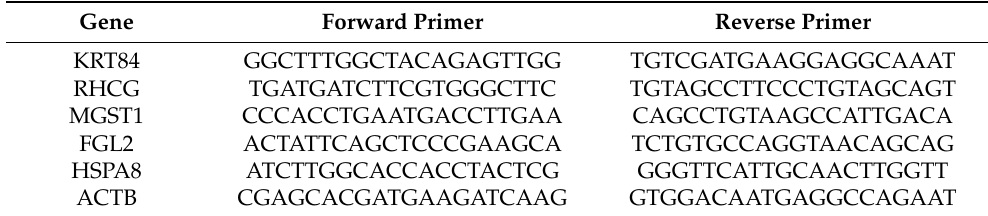
Table 2. The sequence of the primers used in the qPCR